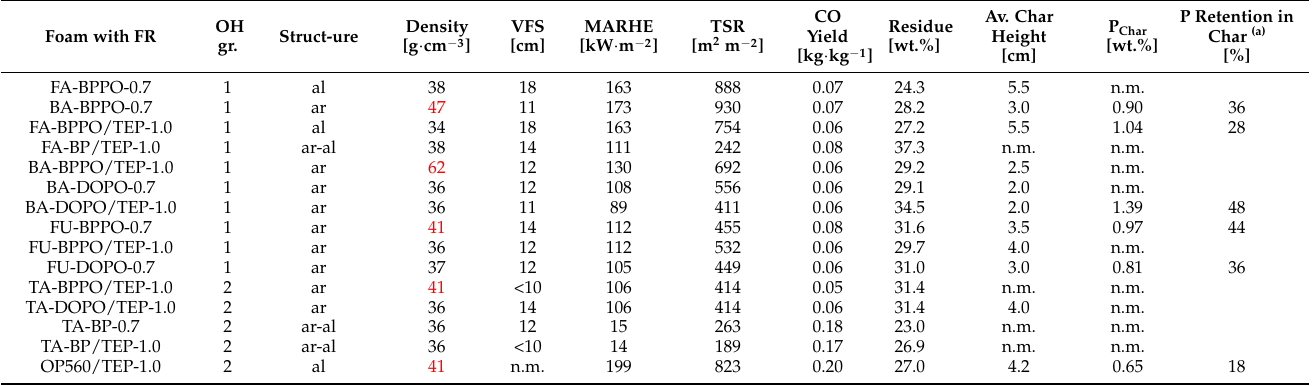
Table 8. Summary of fire-relevant parameters and chars remaining after cone calorimeter tests of the open-cell PIR foams ( WA V > 20% ) .